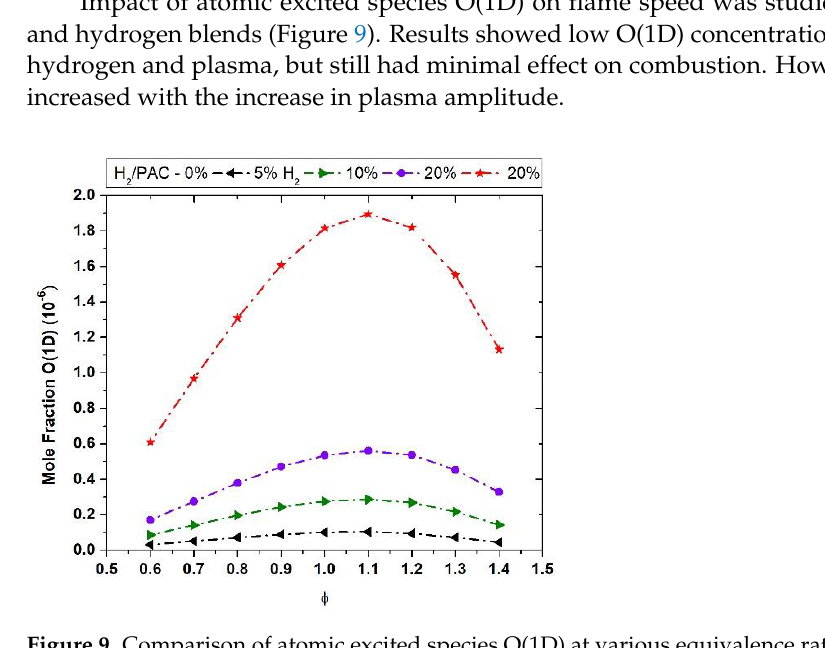
Figure 8. Comparison of molecular excited species O 2 (1 ∆ ) at various equivalence ratios using different H 2 contents with or without NSPD.